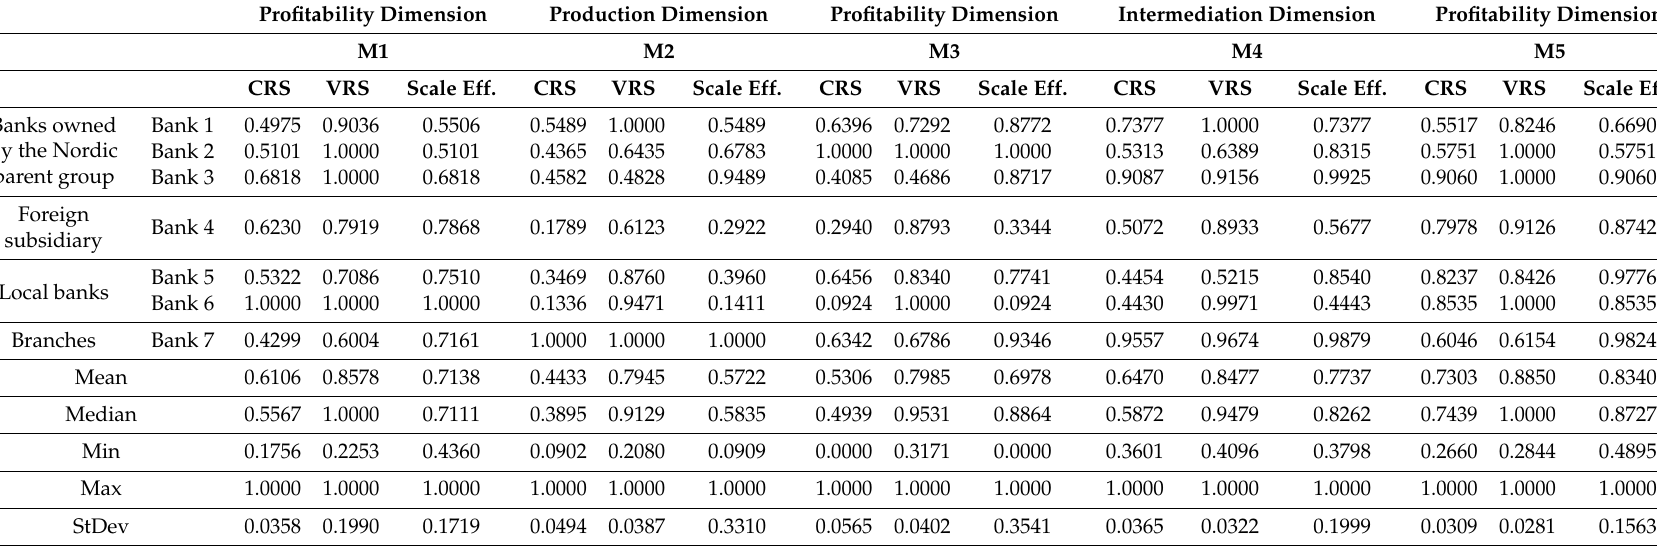
Table 4. Average efficiency scores estimated for the Lithuanian banks using M1–M5 models and descriptive statistics of M1–M5